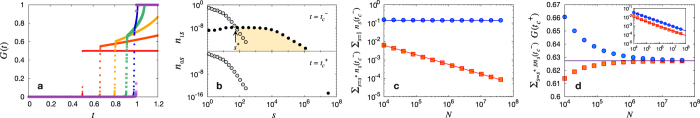
Numerical tests of necessary conditions for type-II DPT in TCA model.(a) G(t) vs. t in the TCA model for various values of p for a system size of N = 105. From left to right, p = 0,0.2,0.4,0.6,0.8, and 1.0. (b) The cluster size distributions of black clusters n0s(•) and white clusters n1s(•) at  (upper panel) and  (lower panel) for N = 212 × 104. (c)  (◻) and  vs. N. (d)  (◻) and  vs. N. The two data sets converge to the value y0 ≈ 0.63. Inset:  (◻) and  vs. N, respectively. The slopes of the guidelines for (◻) in (c) and the inset of (d) are equal to −0.52. The data sets for (b), (c), and (d) are obtained for p = 0.5.